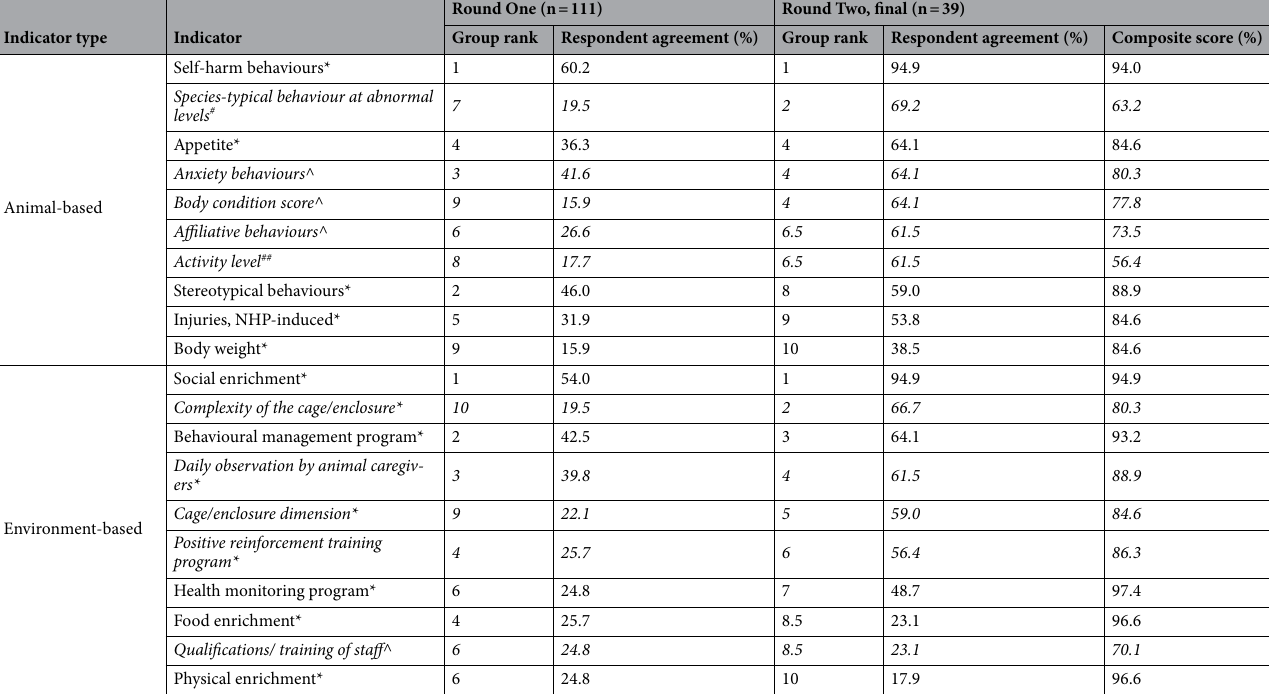
Table 5. Expert ranking of welfare measures. Italics = indicators eliminated from experts’ top 10 between rounds one and two. *Valid, reliable, and feasible. ^Less reliable. # Less reliable or feasible. ## Less valid, reliable, or